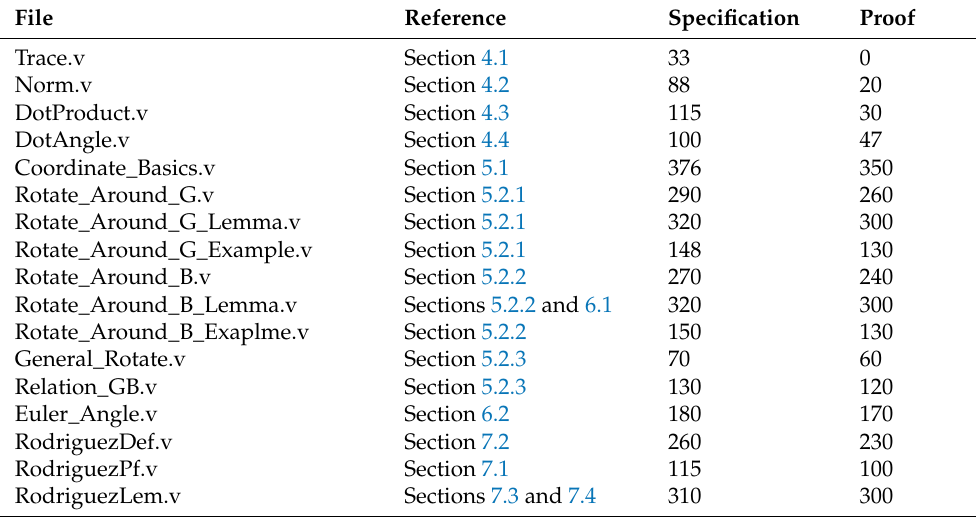
Table 1. Overview of the formal verification of robot rotary